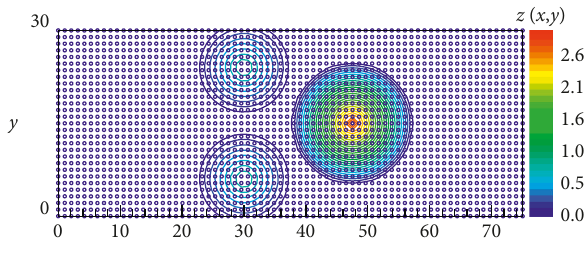
Figure 8: The computational domain, RBF collocation points, and bed contours of the dam break problem over